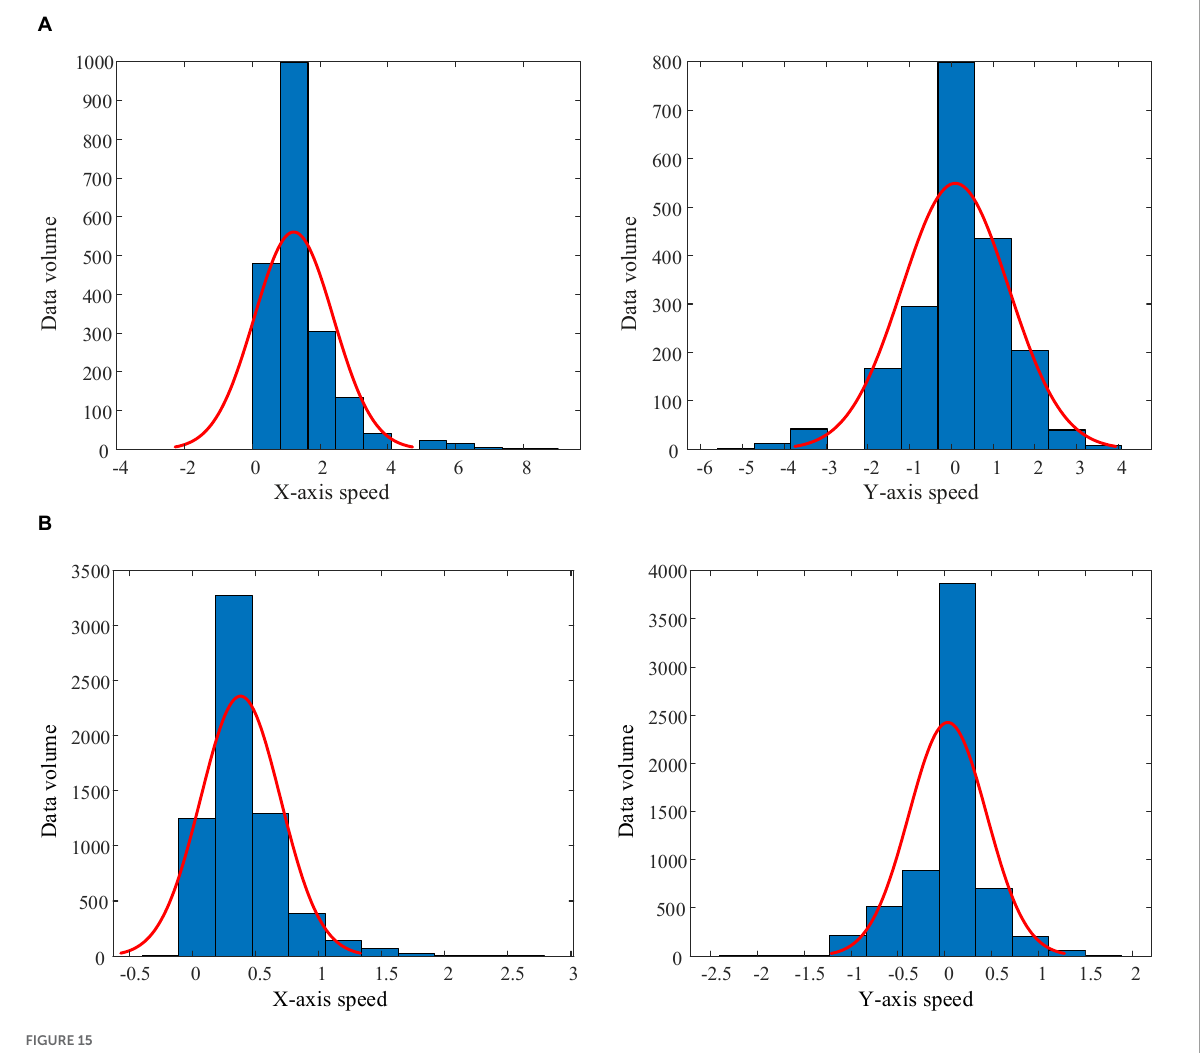
FIGURE15 Histograms and fitting curves of the speed distributions of the robots controlled by aggressive style and conservative style subjects. (A) Aggressive style subject. (B) Conservative style